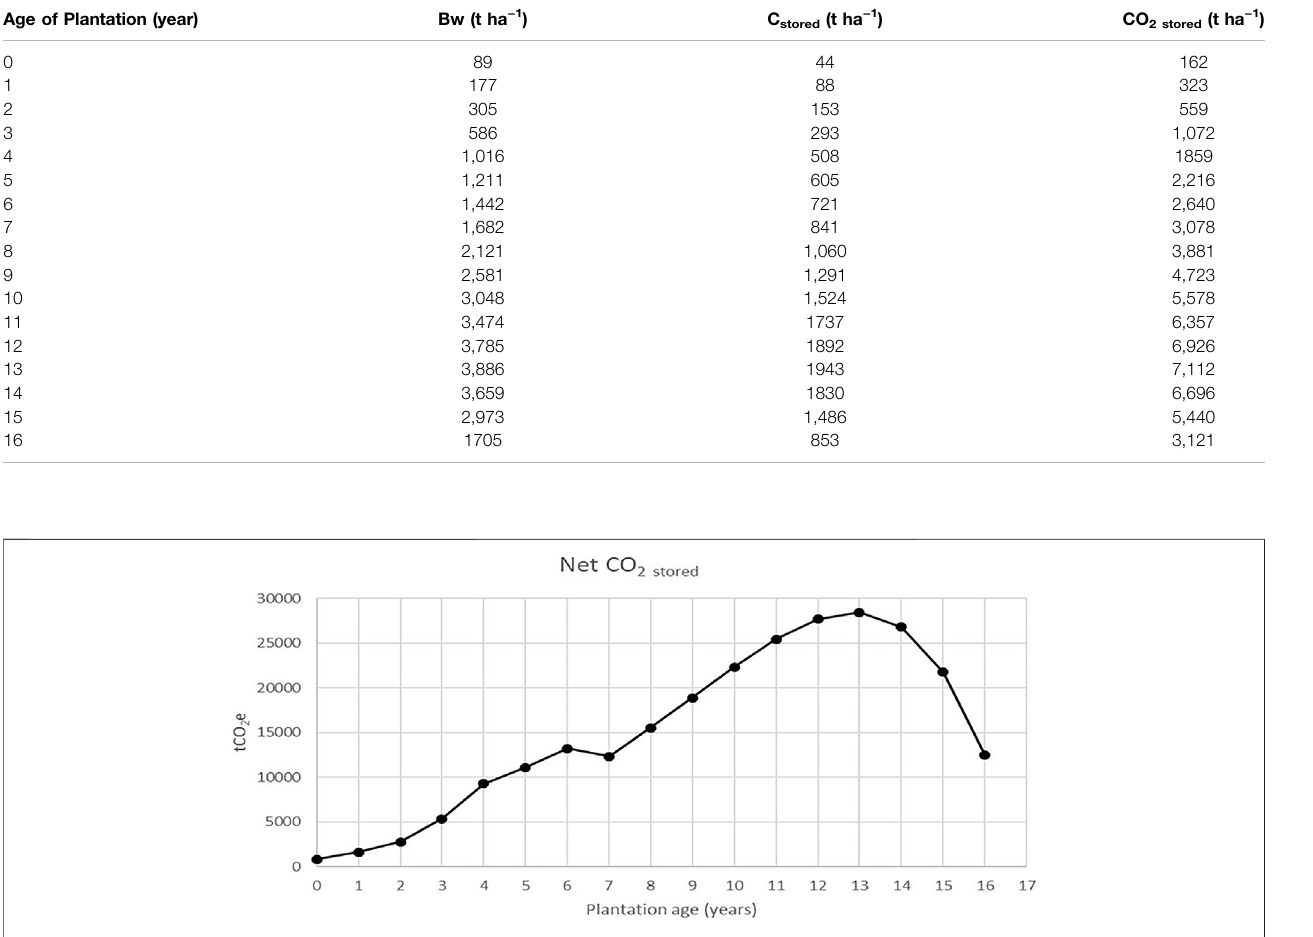
Frontiers in Environmental Science |